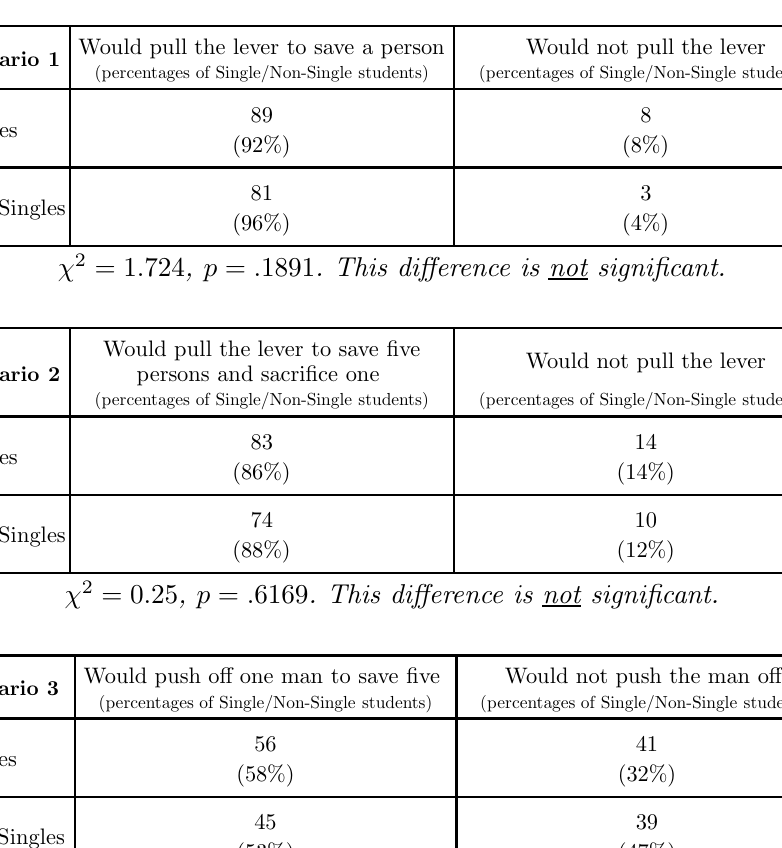
Results of Ill-informed Bystander , Bystander at the Switch , and Fat Man scenarios for students of Economics and